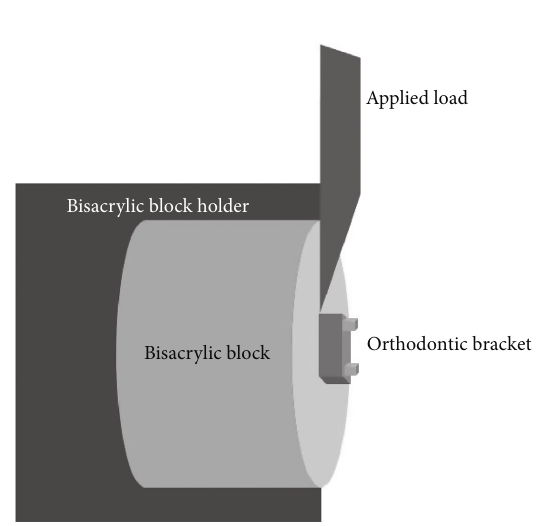
Figure 1: Illustrated diagram for the shear bond strength